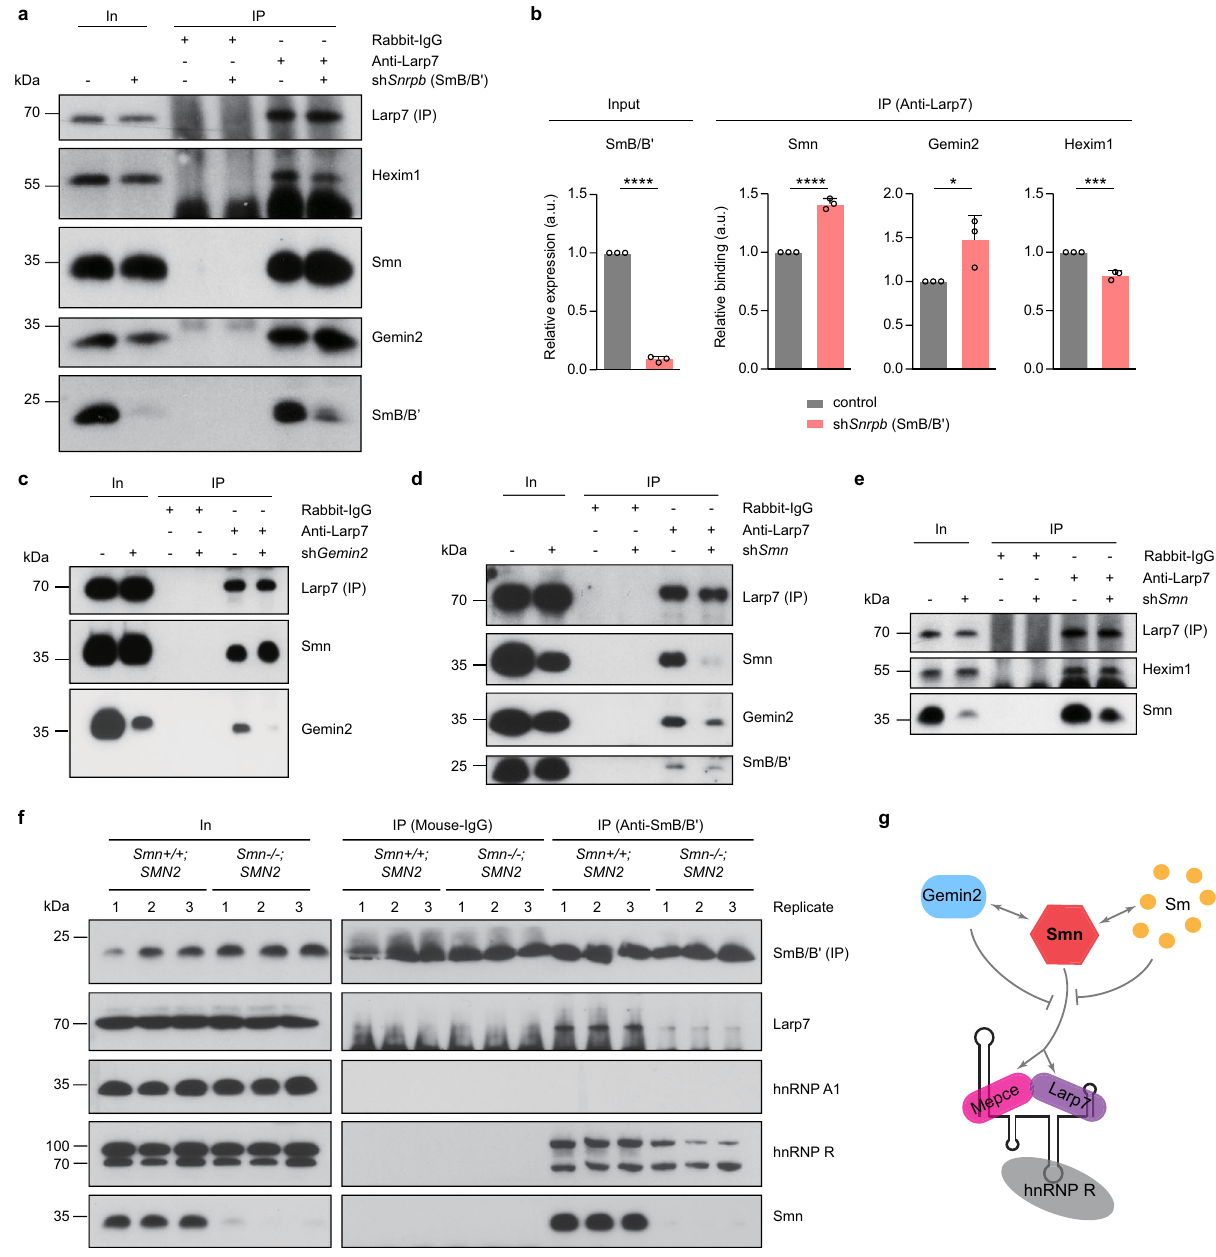
Fig. 5 Depletion of individual components of the Smn complex alters its binding to Larp7. a Western blot analysis of proteins co-immunoprecipitated by anti-Larp7 from control and SmB/B ’ knockdown (sh Snrpb ) NSC-34 cells. b Quanti fi cation of Western blot signals in a . Data are mean ± s.d.; * P ≤ 0.05; *** P ≤ 0.001; **** P ≤ 0.0001; unpaired two-tailed t-test ( n = 3). c Co-immunoprecipitation of proteins by anti-Larp7 from control or Gemin2 knockdown (sh Gemin2 ) NSC-34 cells. d , e Co-immunoprecipitation of proteins by anti-Larp7 from control or Smn knockdown (sh Smn ) NSC-34 cells. f Co-immunoprecipitation of proteins by anti-SmB/B ’ from brains of Smn + / + ; SMN2 or Smn − / − ; SMN2 mice. Note that the immunosignal at 25kDa for mouse-IgG immunoprecipitation is non-speci fi c from the antibody light chain. g Model of Smn interactions with 7SK/hnRNP R. Source data are provided as a Source Data fi